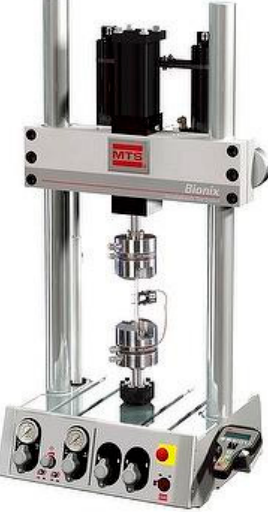
Figure 3. Bionix Servohydraulic Test System machine by MTS. Table 1. Displacements given to specimens in the experimental tests. Samples